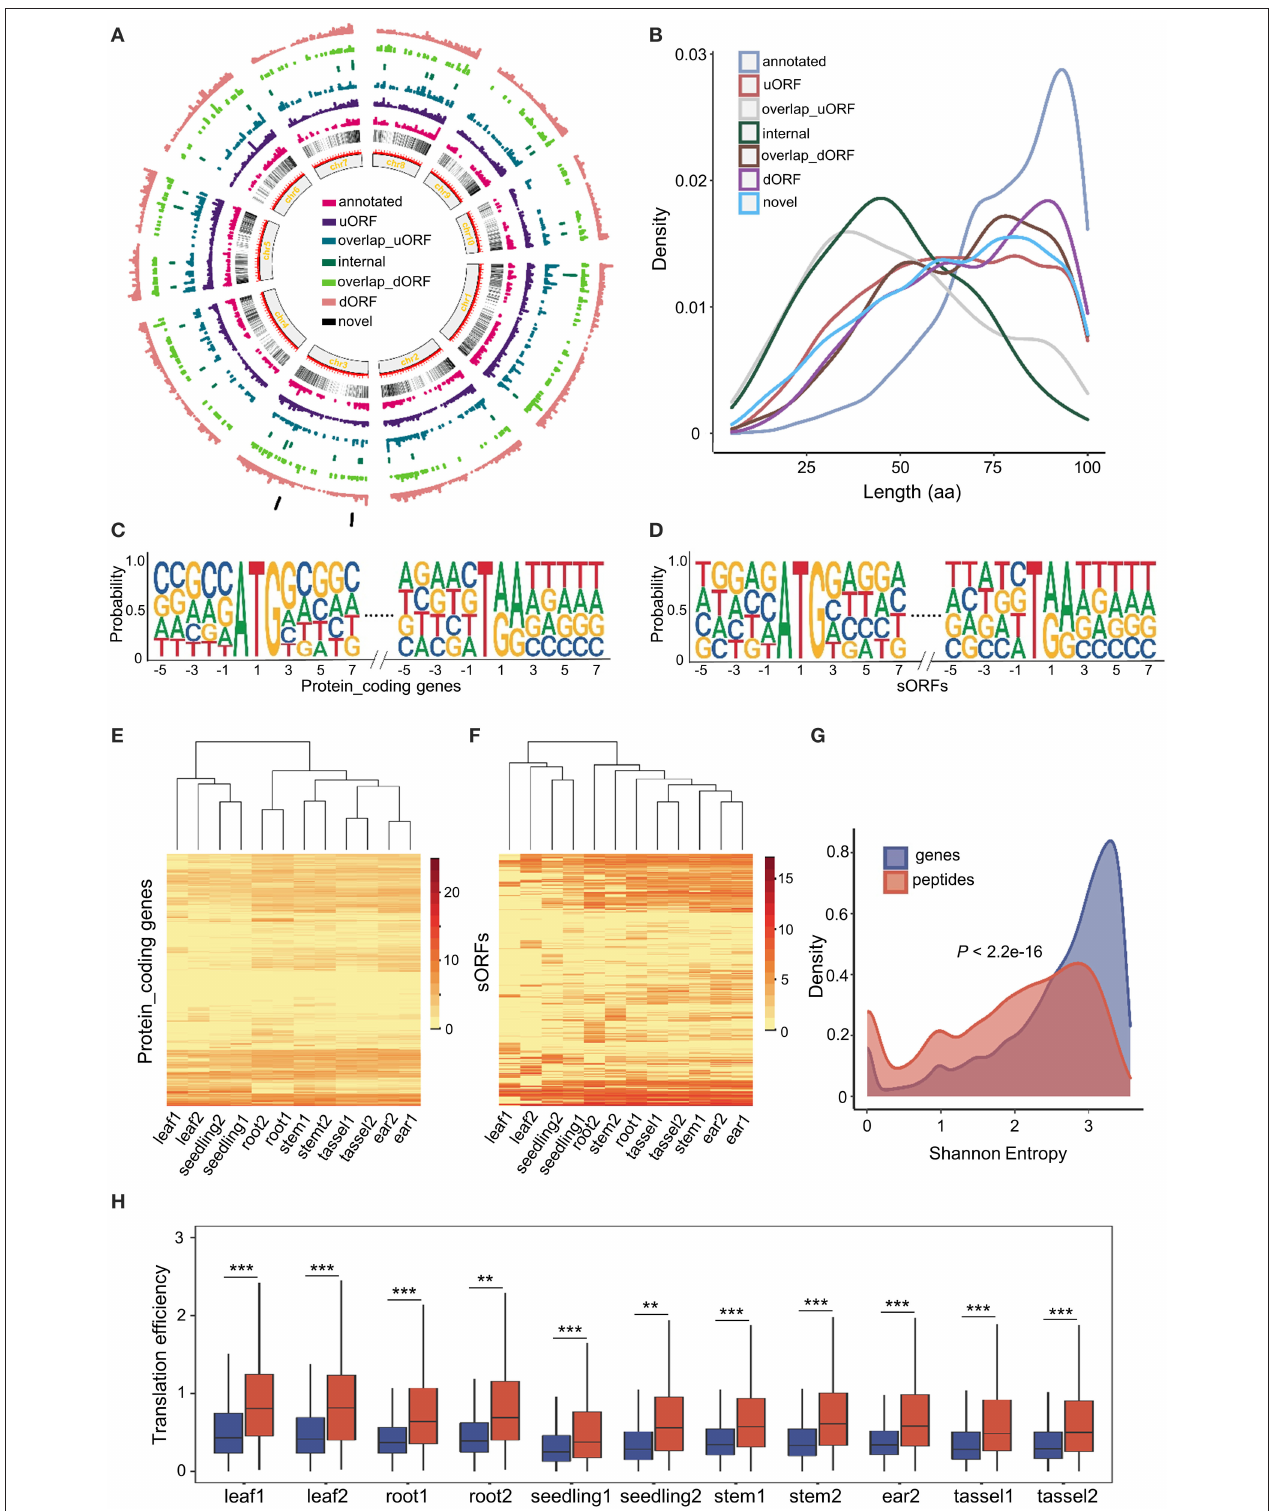
FIGURE 2 | Genome-wide characterization of sORFs in maize. (A) Distribution of different kinds of sORFs in the maize genome. (B) Length distribution of different kinds of sORFs. (C,D) Nucleotide features around start and stop codon sites of conventional genes and sORFs. (E,F) Heatmap of expression levels and unsupervised tissue hierarchical trees of conventional genes and sORFs, respectively. (G) Shannon entropy distribution of conventional genes (in blue) and sORFs (in red). (H) Differentiation of translation efficiency (TE) between conventional genes (mentioned in blue color) and sORFs (mentioned in red color). *,** and *** indicate P -values of less than 0.05, 0.01 and 0.001, respectively (Mann–Whitney U -test).